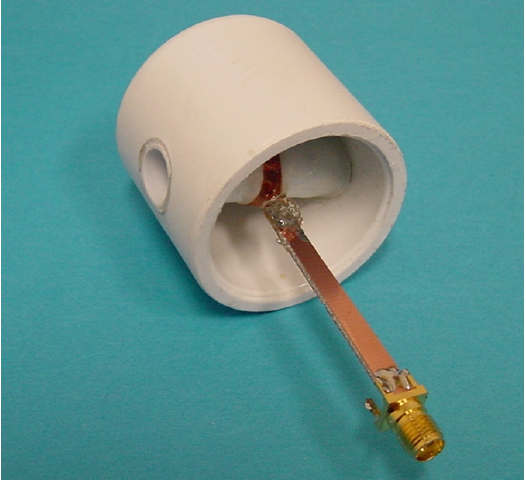
Figure 3b. Mounting assembly for magnetoelastic sensor